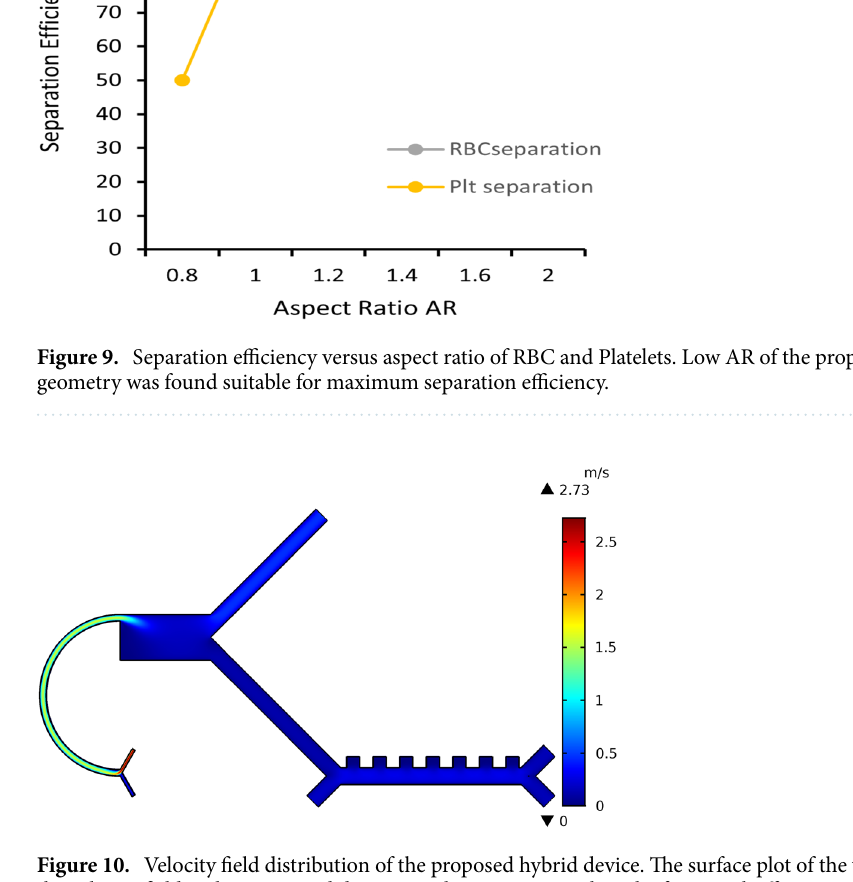
Figure 10. Velocity field distribution of the proposed hybrid device. The surface plot of the velocity indicates the velocity field within proposed device in color spectrum. When the focusing buffer is injected, the velocity around its inlet is high (represented by red region). The cell suspension was injected with a low velocity, thus lowering the fluid stream velocity in the curved contracted region (represented by green region). As the fluid enters in the expanded region it further reduces the velocity (represented by blue region). At the end of the inertial stage, the single channel is bifurcated, hence dividing, and then reducing the volumetric flow. DEP stage channel size is further increased. This equalization of hydraulic resistance promotes the uniform distribution of flow across the DEP stage, where an evenly blue spectrum is obtained with fluid flow